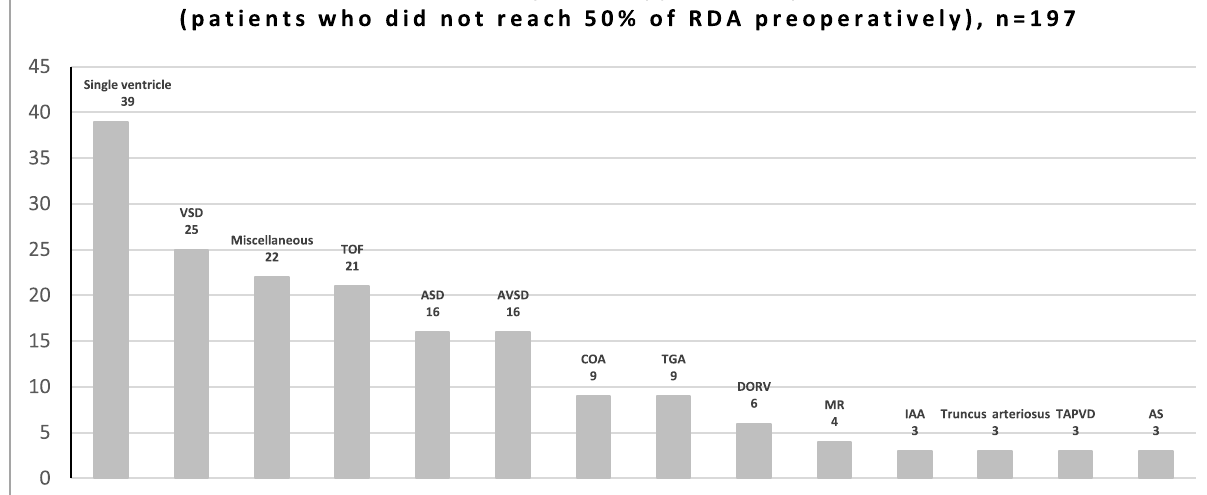
Fig. 1 Cardiac pathology for group 1: VSD, ventricular septal defect; TOF, tetralogy of Fallot; ASD, atrial septal defect; AVSD, atrio ventricular septal defect; COA, coarctation of the aorta; TGA, transposition of great vessels; DORV, double outlet right ventricle; MR, mitral regurge; IAA, interrupted aortic arch; TAPVD, total anomalous pulmonary venous drainage; AS, aortic stenosis